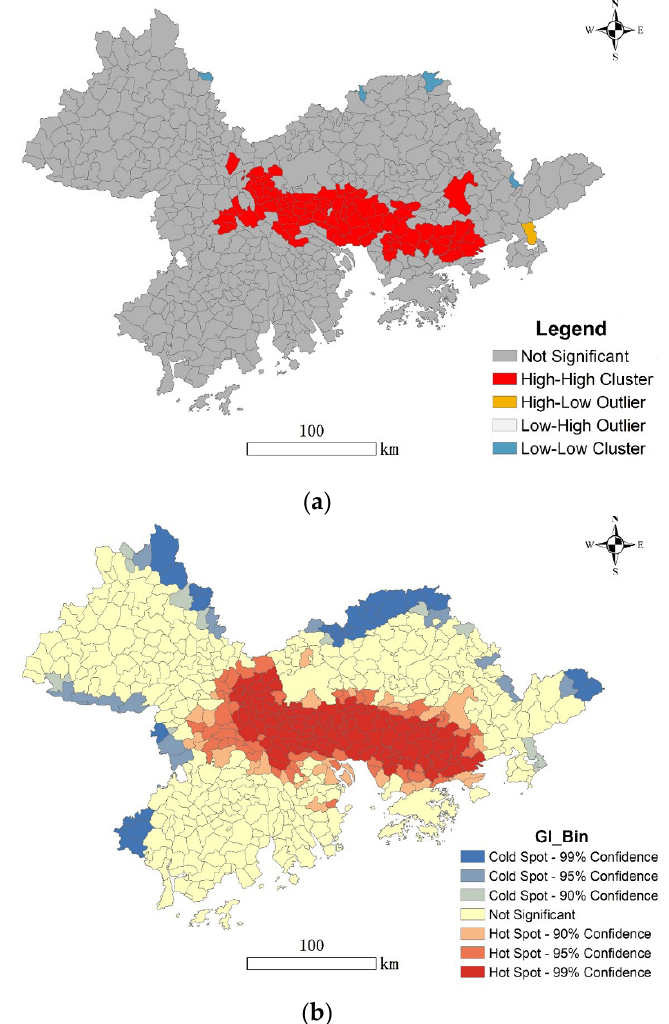
Figure 8. Map of spatial clustering ( a ) and hot–cold regions of land-use-change frequency ( b ).